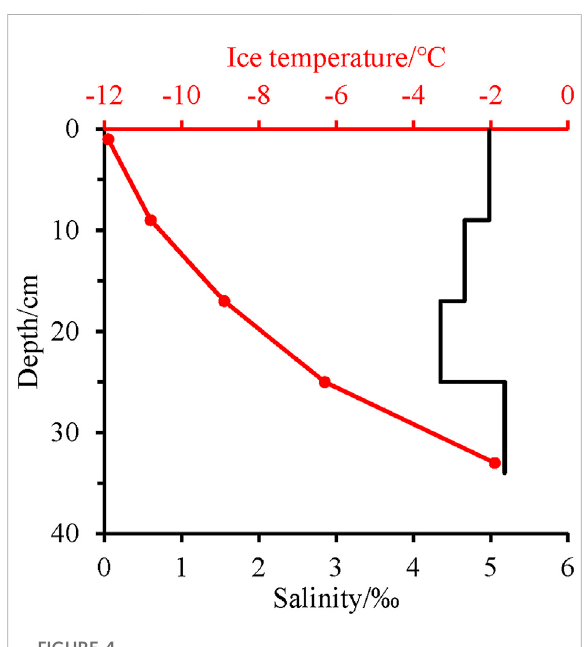
FIGURE 4 Vertical pro fi les of temperature and salinity of the sea ice in the fi